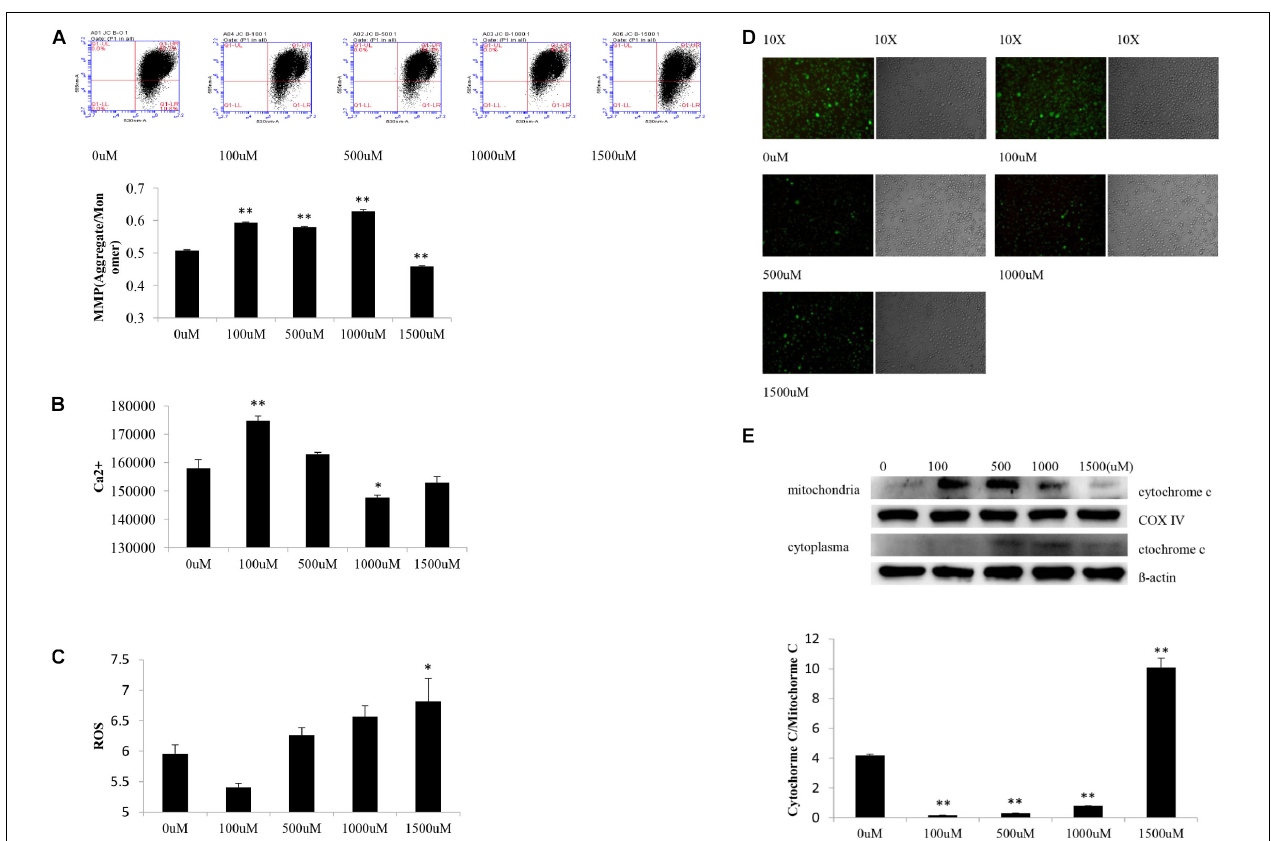
FIGURE 2 | Changes of SY5Y cells subjected to OGD and different concentration NaSH treatment. (A) Compared to OGD group, increased MMP levels appeared in cells subjected to OGD and 100, 500, and 1,000 µ M NaSH treatment, and decreased MMP levels appeared in cells subjected to 1,500 µ M treatment ( n = 3, P < 0.01). (B) Compared to OGD group, increased Ca 2 + levels appeared in OGD and 100 µ M of NaSH treatment group ( P < 0.01) while decreased Ca 2 + levels appeared in OGD and 1,000 µ M of NaSH treated ones ( n = 3, P < 0.05). (C) Increased ROS levels appeared in cells subjected to OGD and 1,500 µ M treatment compared to OGD group ( n = 3, P < 0.05). (D) Compared to OGD group, immunofluorescence showed similar green fluorescence in cells subjected to OGD and 100 µ M NaSH treatment, while lower green fluorescence in cells subjected to OGD and 500, 1,000, and 1,500 µ M NaSH treatment. (E) Compared to OGD group, increased cytochrome C release appeared in cells subjected to OGD and 1,500 µ M treatment but decreased in cells subjected to OGD and 100, 500, and 1,000 µ M treatment as well ( n = 3, P < 0.01). ∗∗ P < 0.01, ∗ P < 0.05, analyzed by one-way ANOVA and Bonferroni post hoc